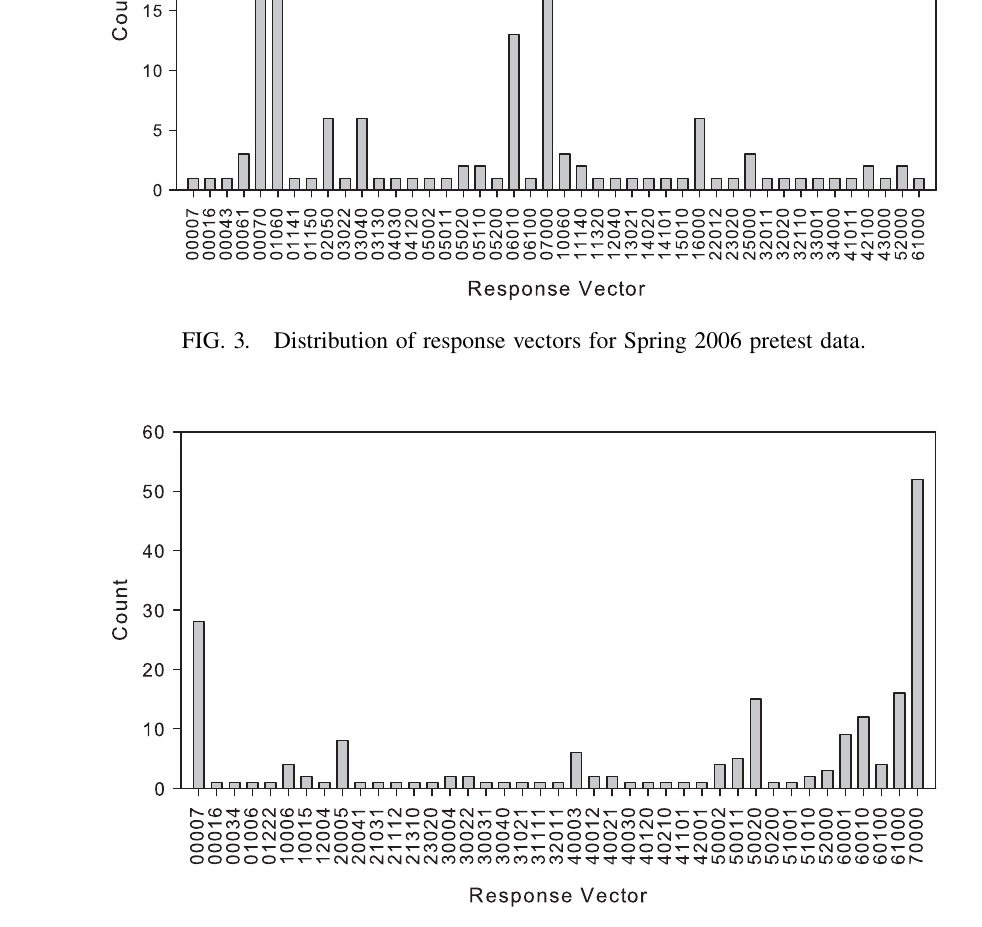
FIG. 4. Distribution of response vectors for Fall 2006 pretest data.